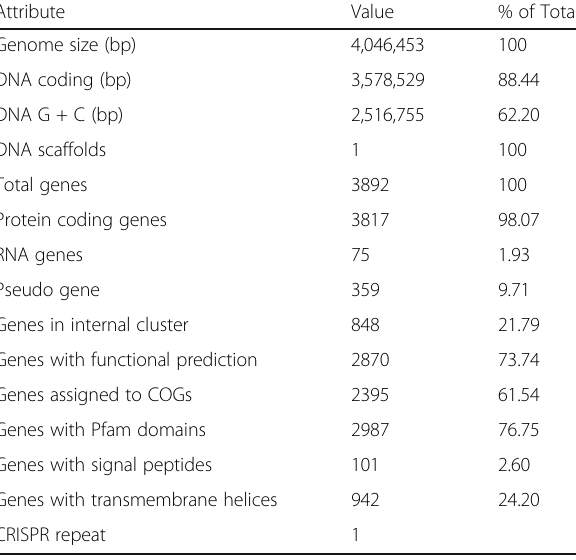
Table 3 Genome statistics of Arthrobacter alpinus R3.8